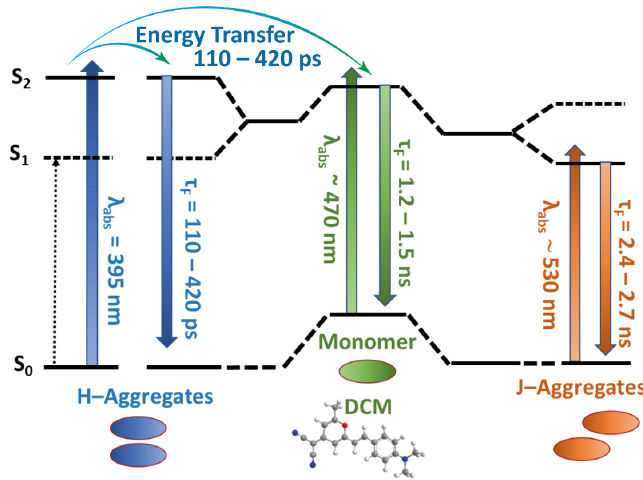
Scheme 2. Illustration (not in scale) of the energetic levels of DCM monomers, H- and J-aggregates. The dotted arrow corresponds to a forbidden transition, while the filled ones reflect the absorption and emission transitions together with the corresponding wavelengths and lifetimes. The scheme also illustrates the EnT happening between H-aggregates and from H-aggregates to